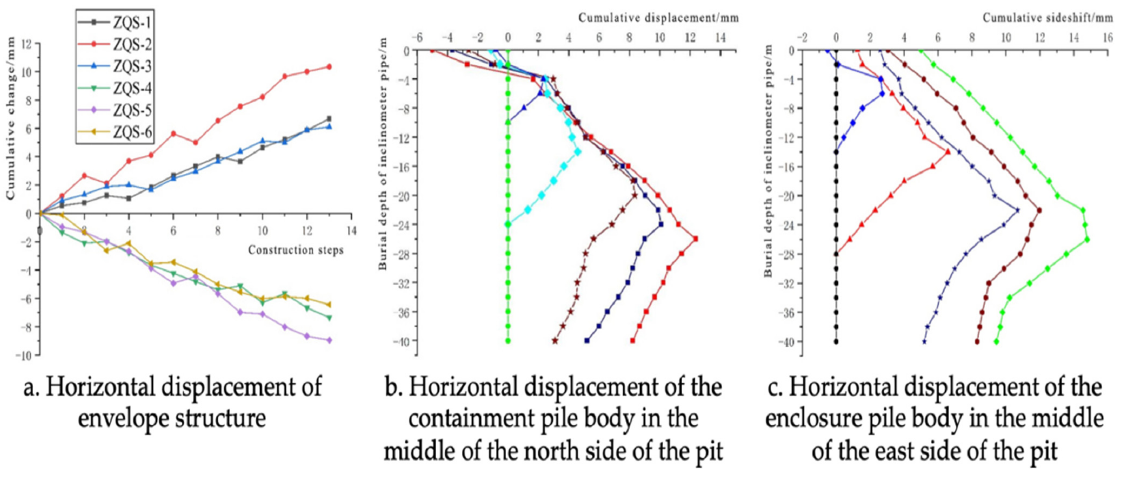
Figure 13. Horizontal displacements of the foundation pit under different FPE steps.